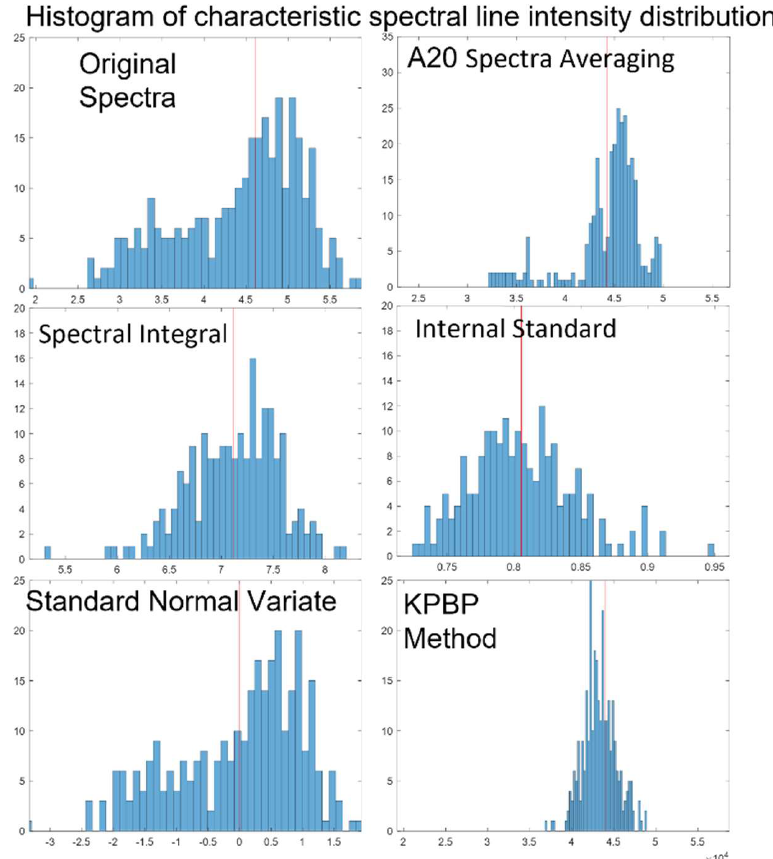
Figure 12. Fe 406.33 nm intensity distribution histograms of the original spectra and the results of the 5 standardization methods.